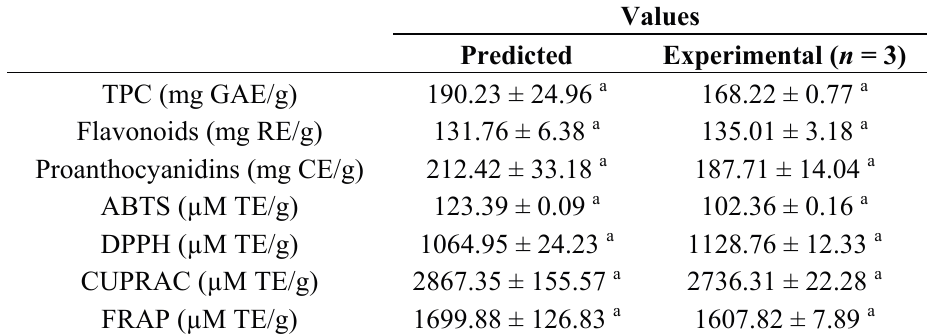
Table 5. Validation of the predicted values for TPC, flavonoids, proanthocyanidins and antioxidant